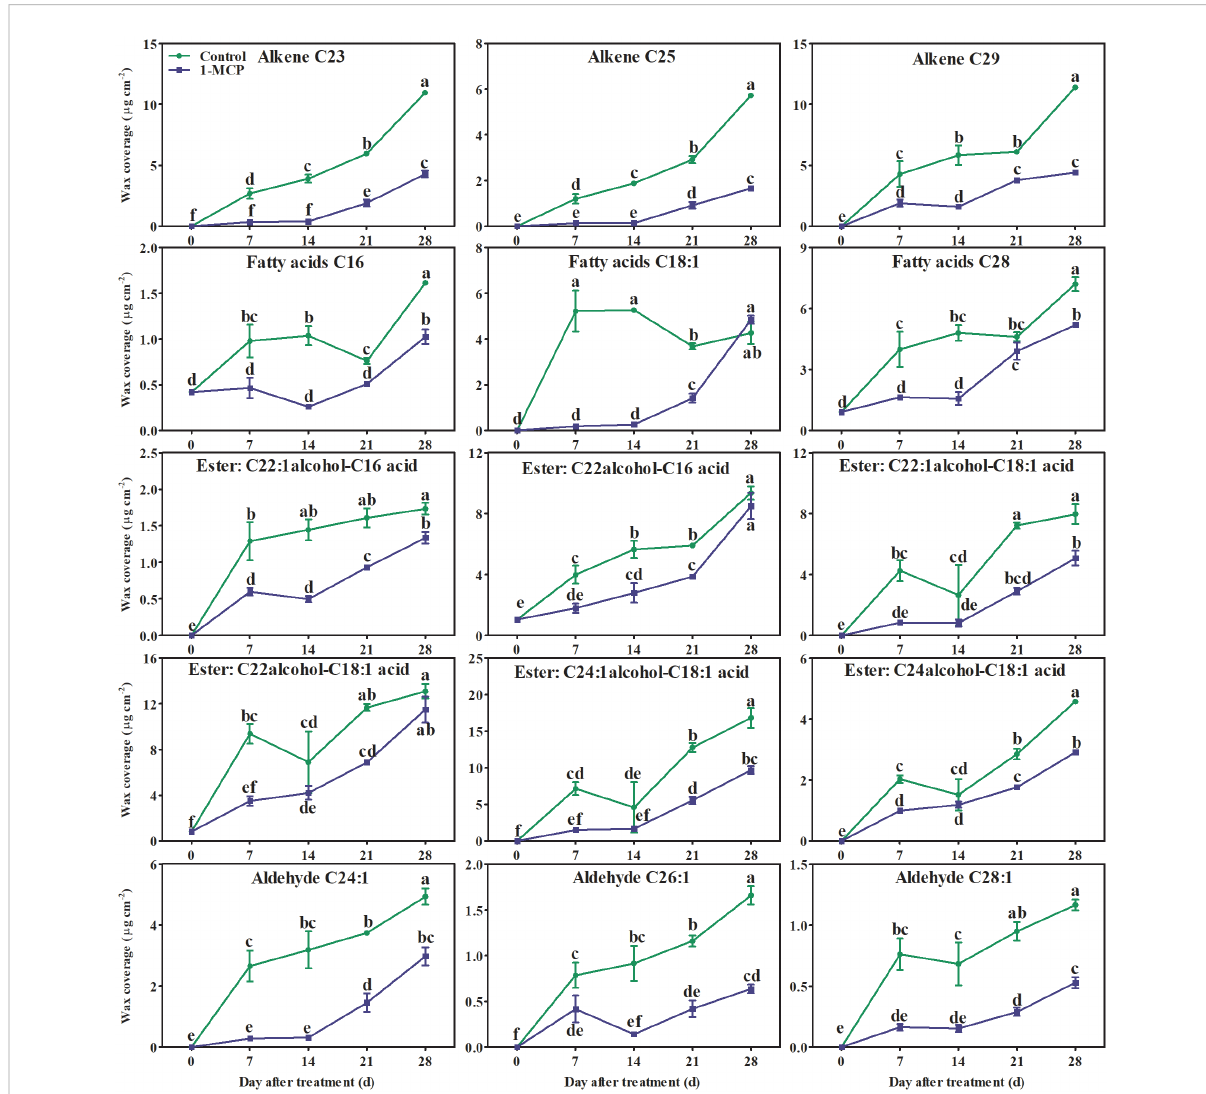
FIGURE 4 Effects of 1-MCP treatment on the principal components (alkenes, fatty acids, esters, and ole fi nic aldehydes) of wax on the surface of ‘ Yuluxiang ’ pear during storage. Data are mean ± SE ( n = 3); values labeled with different letters represent a signi fi cant difference at p